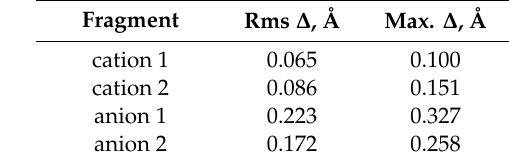
Table 1. The root-mean-square Cartesian displacements (Å) between the Rietveld-refined and DFT-optimized fragments in fosfomycin tromethamine.